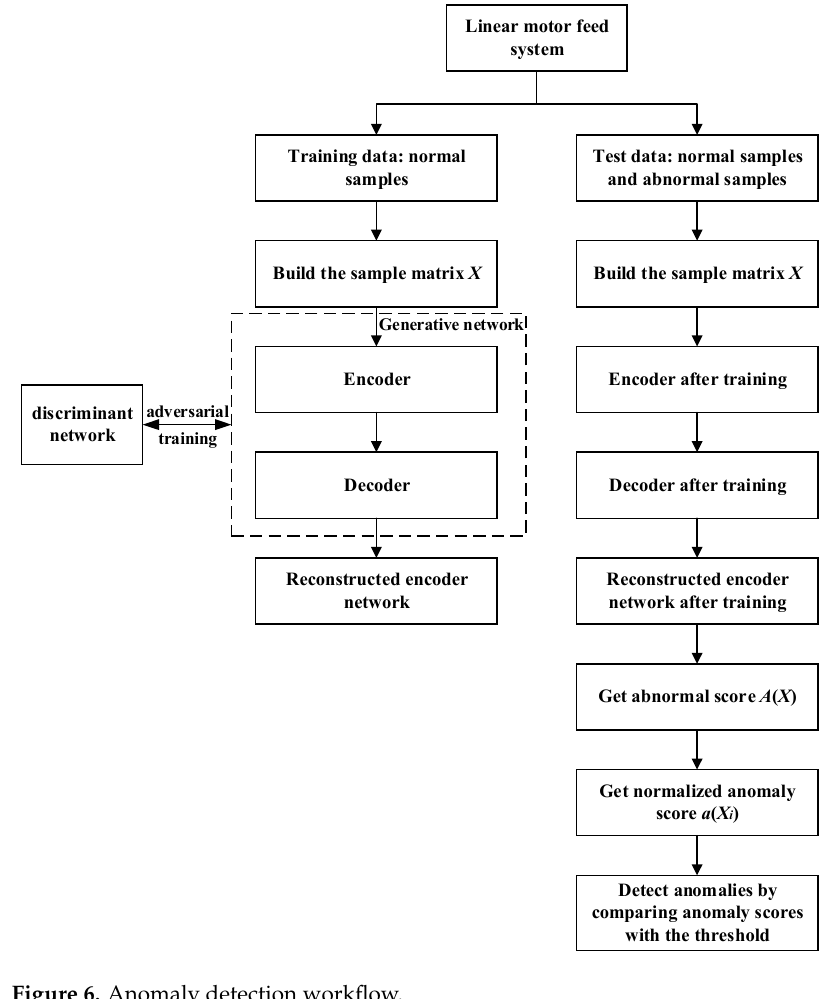
Figure 6. Anomaly detection workflow.